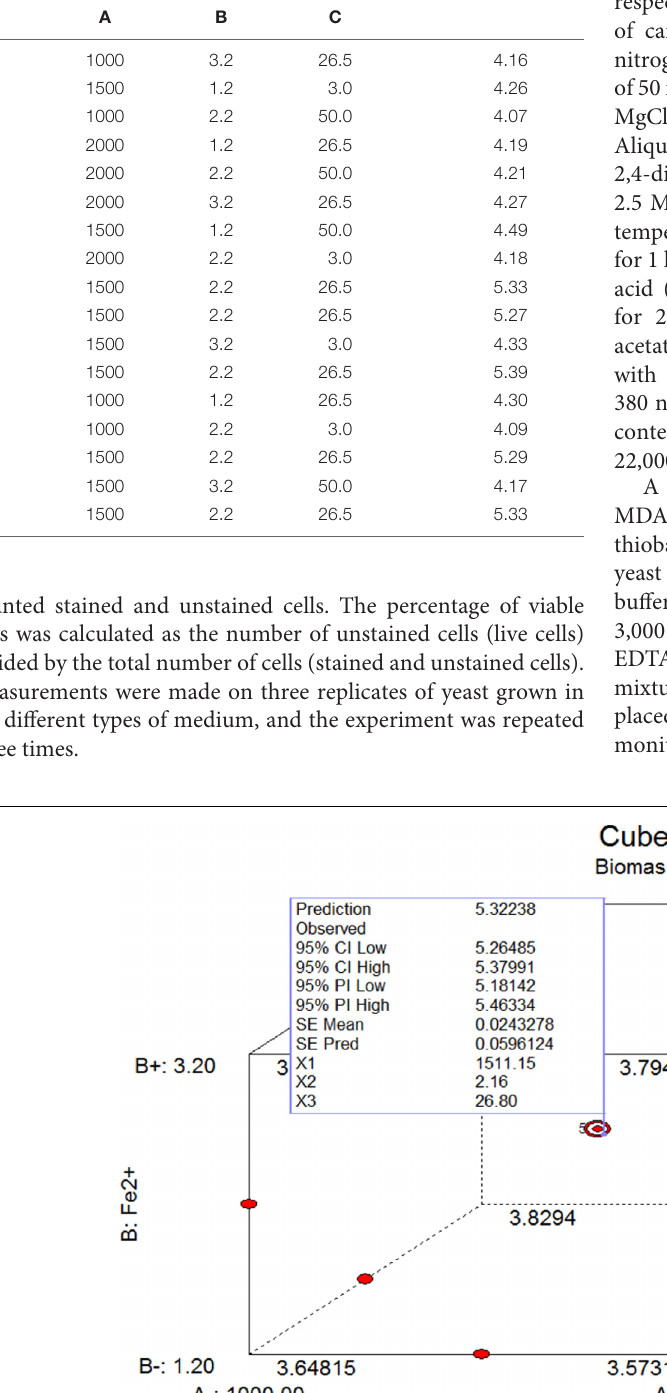
Frontiers in Microbiology |